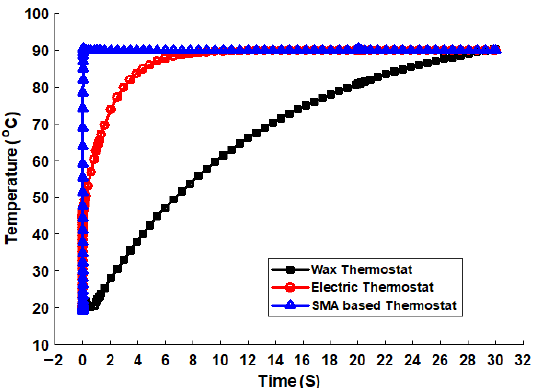
Figure 10. Comparison of the different thermostat types based on their response to the change in the flow direction of the engine coolant.